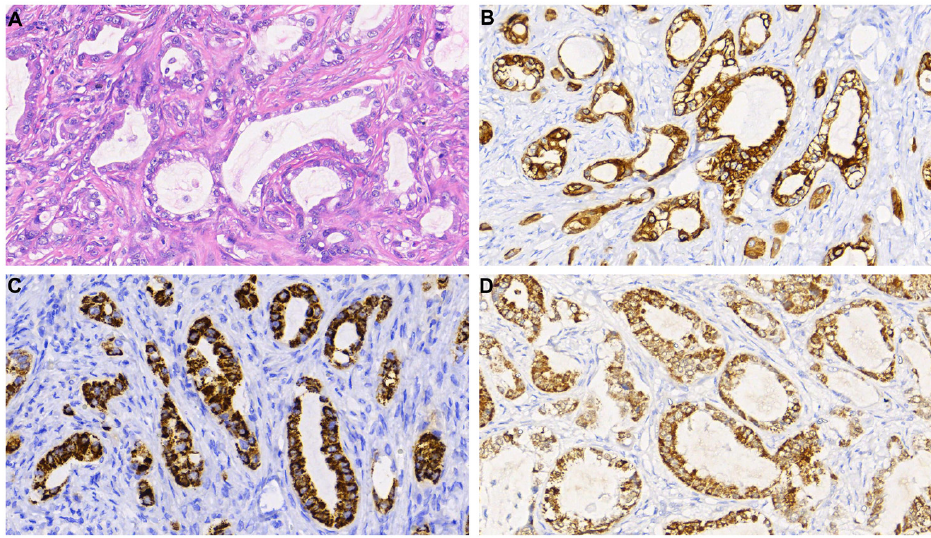
Figure 3. Histopathologic analysis of the brain metastasis tumour sample. Hematoxylin and eosin-stained histological sections show adenocarcinoma, comprised cells with increased nuclear/cytoplasmic ratio and prominent nucleoli forming glands ( A ). Neoplastic cells display strong cytoplasmic positivity for cytokeratin 7 ( B ), strong cytoplasmic positivity for HEP-PAR ( C ), and both nuclear and cytoplasmic staining for TTF1 ( D ). Magnification: 300×.